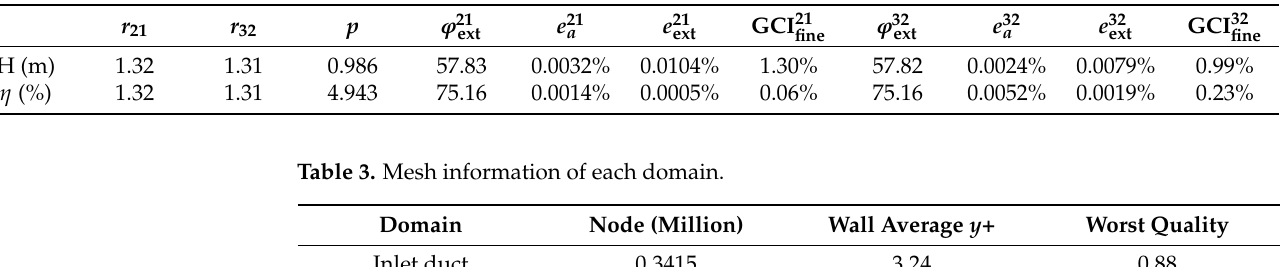
Table 2. Computed discretization errors in head and efficiency.